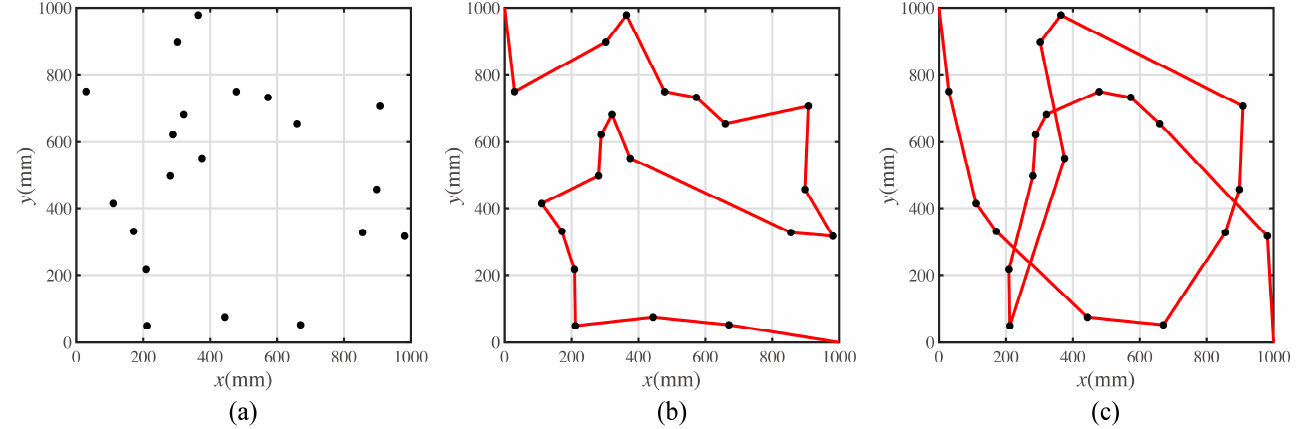
Figure 3. The target point distribution and the path solution. ( a ) Target points placed in the workspace. ( b ) The optimal path with the shortest length. ( c ) The optimal path with the least rotation.